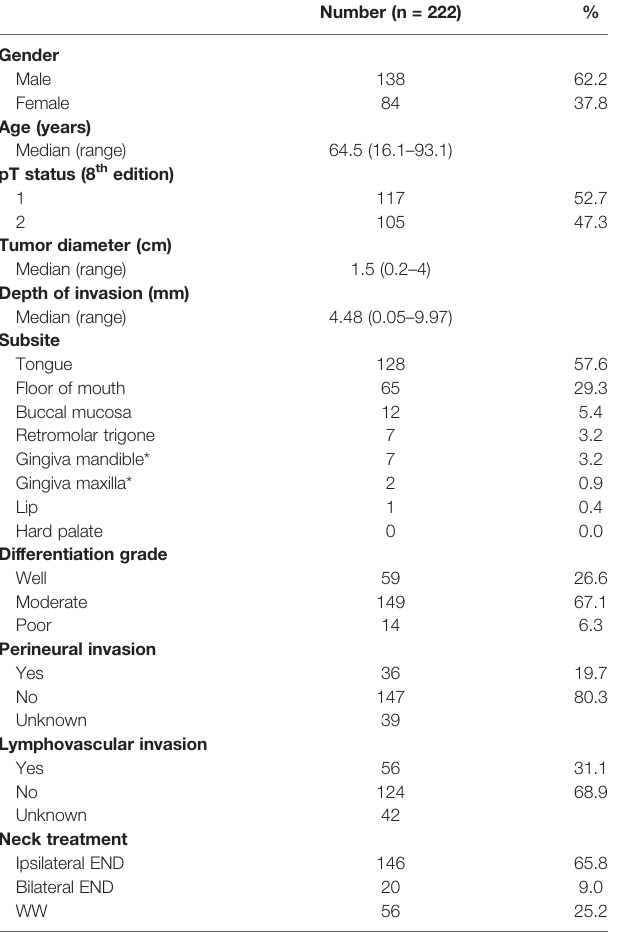
TABLE 1 | Patient and tumor characteristics.